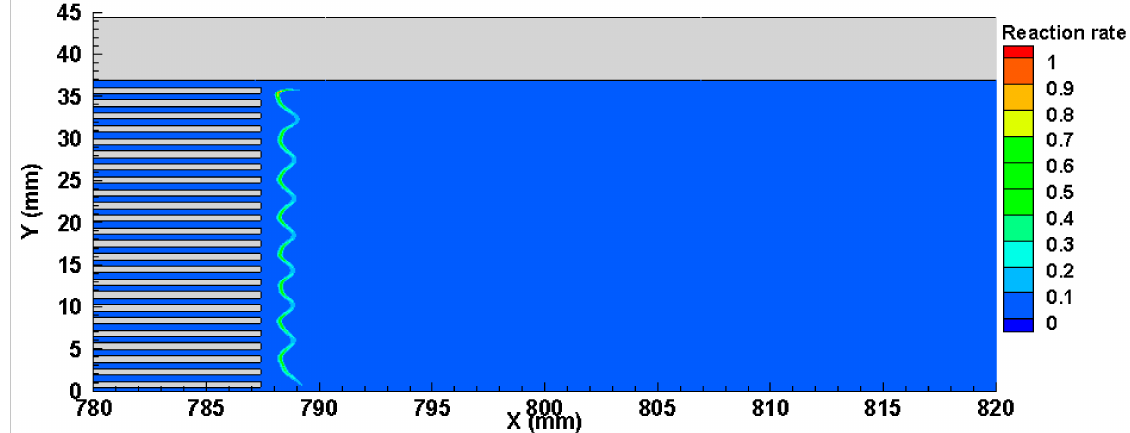
Figure 4. Reaction rate [kmol/m 3 · s] contour plots of the flame stabilizer channels and flame zone.